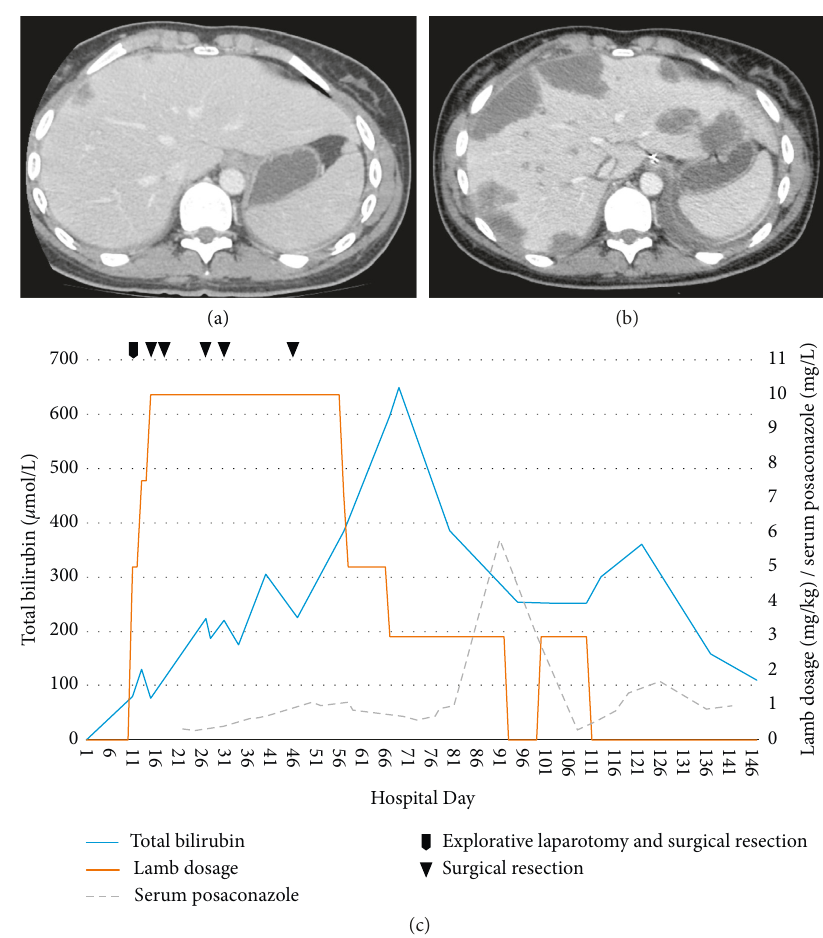
Figure 1: (a) Portal venous phase contrast-enhanced CTshows several small hypoattenuating lesions with slight peripheral enhancement. (b) Two days later, CTshows progression with multiple large hypoattenuating lesions in both the left and right lobe of the liver, suggestive of liver abscesses. (c) Time course of LAmB dosage, serum posaconazole, and serum bilirubin levels. Taking into account the long serum terminal half-life and mean residence time in the liver tissue of LAmB, the graph suggests that LAmB was an important contributor to the cholestasis and hepatotoxicity (as measured by total bilirubin levels) observed in our